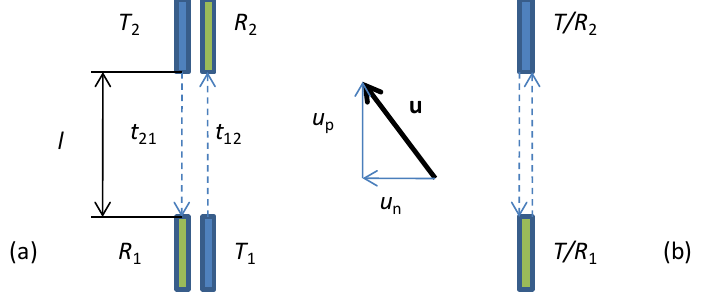
Figure 3. Geometry of ultrasonic transceiver arrangements (one measurement